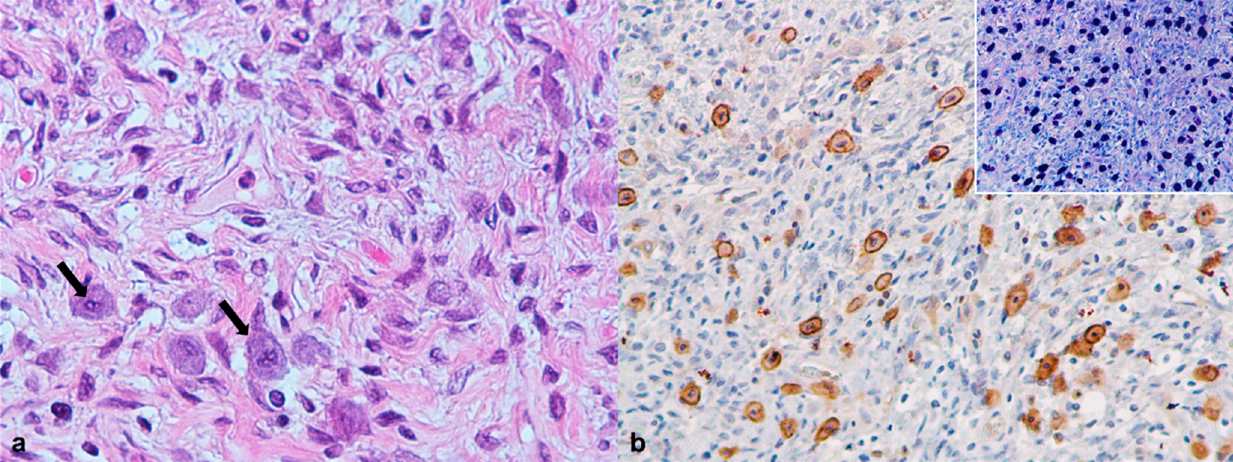
Figure 1. African pygmy hedgehog, subcutaneous tissue. Case 4, Mast cell tumor. ( a ) Presence of round cells supported by abundant collagenous stroma. Cells show high pleomorphism and variable amount of intracytoplasmic basophilic granules (arrows; HE, 100×); ( b ) C-kit immunostaining revealing strong and both membranous and cytoplasmic immunopositivity of neoplastic mast cells. Inset: neoplastic mast cells showing metachromatic cytoplasmic granules (Giemsa, 200×).